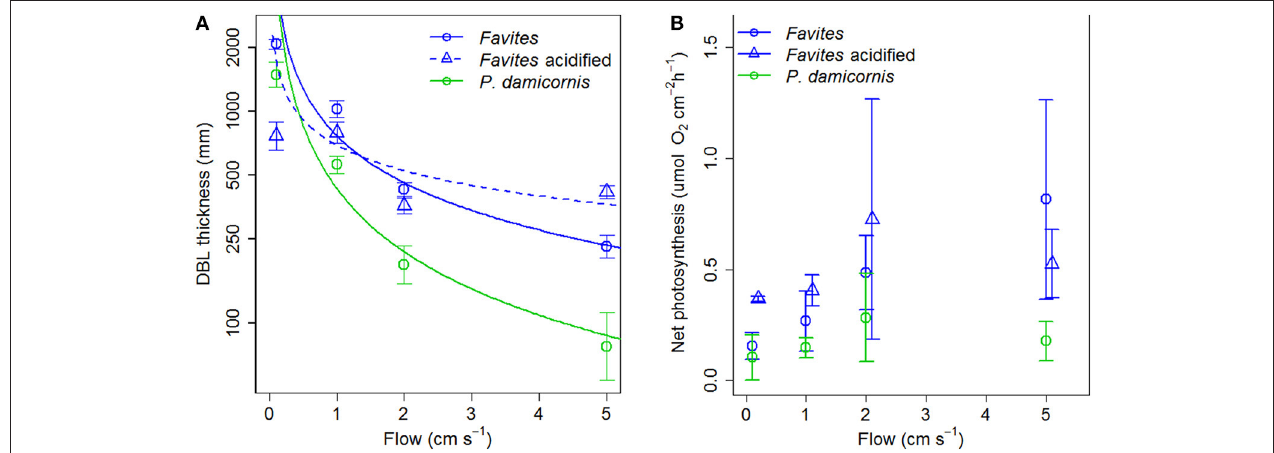
FIGURE 1 | (A) DBL thickness (mm) vs. flow (cm s − 1 ) for Favites (blue circles), Favites (blue triangles) and P. damicornis (green circles). Symbols and error bars represent the mean ± 1.96 * SE ( n = 2 –6). Lines represent the relationship between DBL thickness and flow from fitted power functions (blue solid—DBL Favites = 767 flow − 0.738 , blue dashed—DBL Favites acidified = 691 flow − 0.399 , green solid—DBL P . damicornis = 432 flow − 0.99 ). (B) Net photosynthesis at various flows (cm s − 1 ) for Favites (blue circles), Favites under acidified conditions (blue triangles), and P. damicornis (green circles). Symbols with error bars represent the mean ± 1.96 * SE ( n = 2 –6).